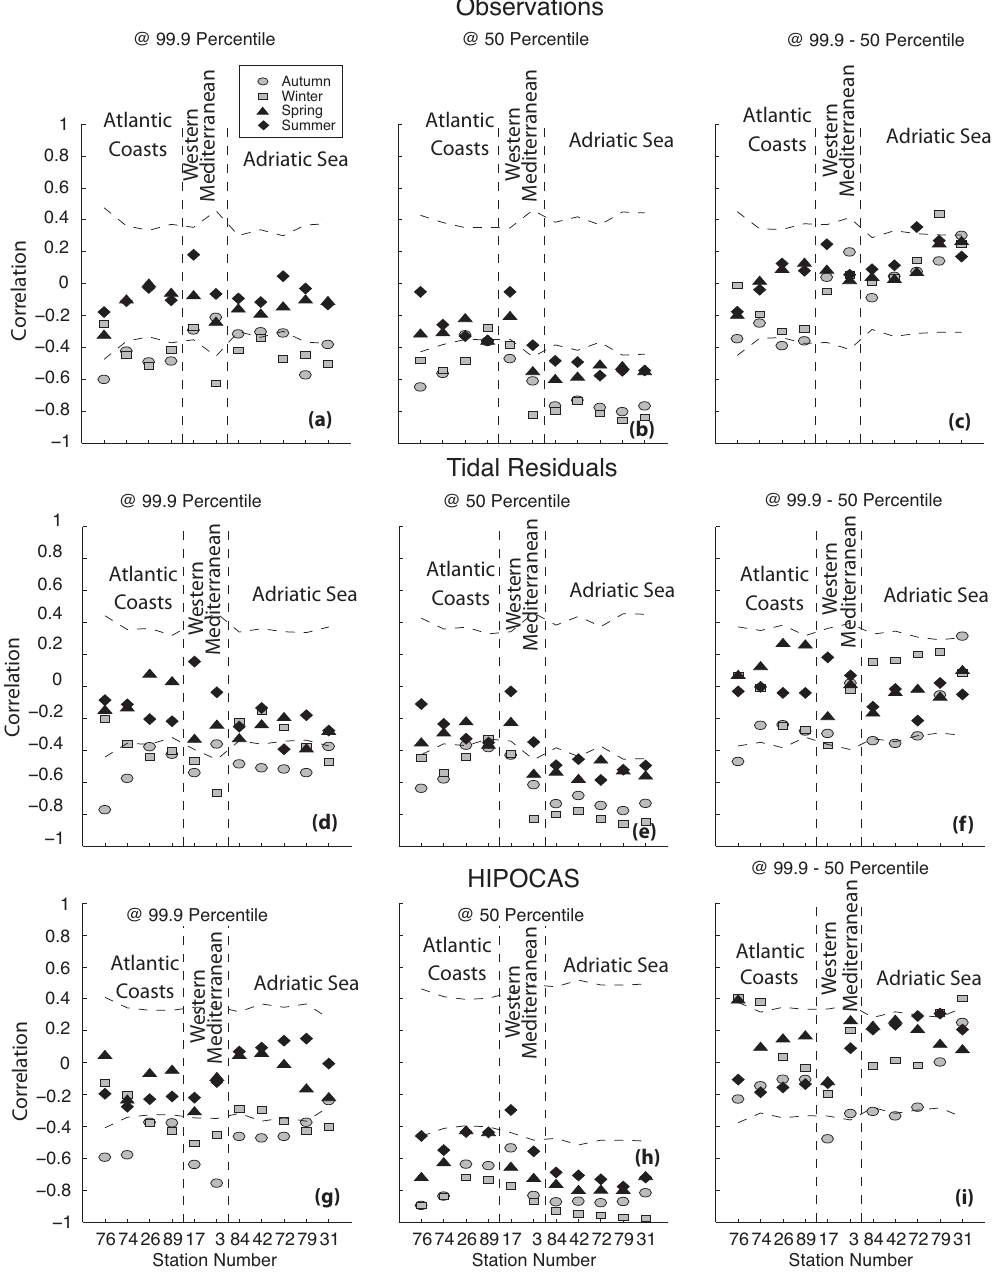
Figure 8. Seasonal correlations of the MOI with the 99.9 percentile, 50 percentile and their difference. Fig. 8. Seasonal correlations of the MOI index with the 99.9 percentile, 50 percentile and their difference. (a–c) for the observed values; (a-c) for the observed values; (d-f) for the tidal residuals; (g-i) for the model values. Each of the seasonal (d–f) for the tidal residuals; (g–i) for the model values. Each of the seasonal correlation coefficients has an associated value in order to be correlation coefficients has an associated value in order to be significant at 95% level. We have plotted the significant at 95% level. We have plotted the highest of the four values as giving the most conservative estimate for the level of significance. highest of the four values as giving the most conservative estimate of level of significance. between the NAO and the 99.9% percentile becomes statisti- cally insignificant when the 50% is subtracted (Fig. 7c). Thus the influence of the NAO at the 99.9% is due to the changes in mean sea